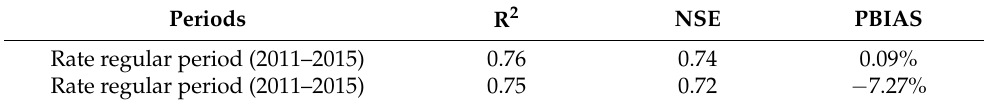
Table 3. Evaluation table of monthly runoff simulated by the SWAT